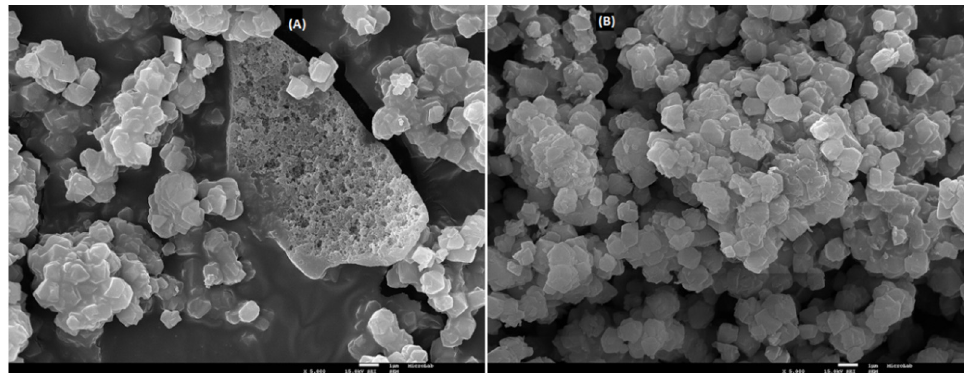
Figure 11. SEM images of z. HY catalyst sample collected after the methanation reaction process, at 300 ◦ C and with 4% ( w / w ) of z. HY catalyst ( A : 2000 x, 10 µ m; B : 5000 x, 1 µ m).